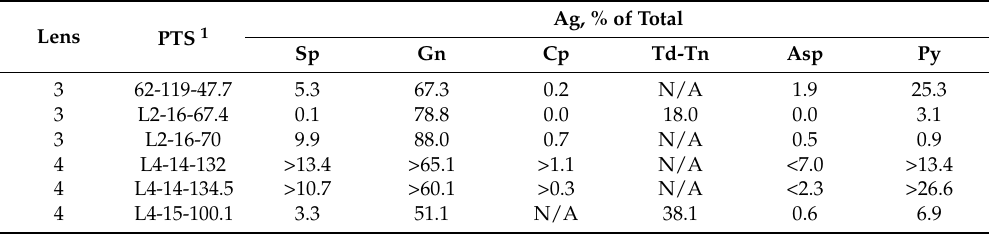
Table 5. Silver distributions by grain